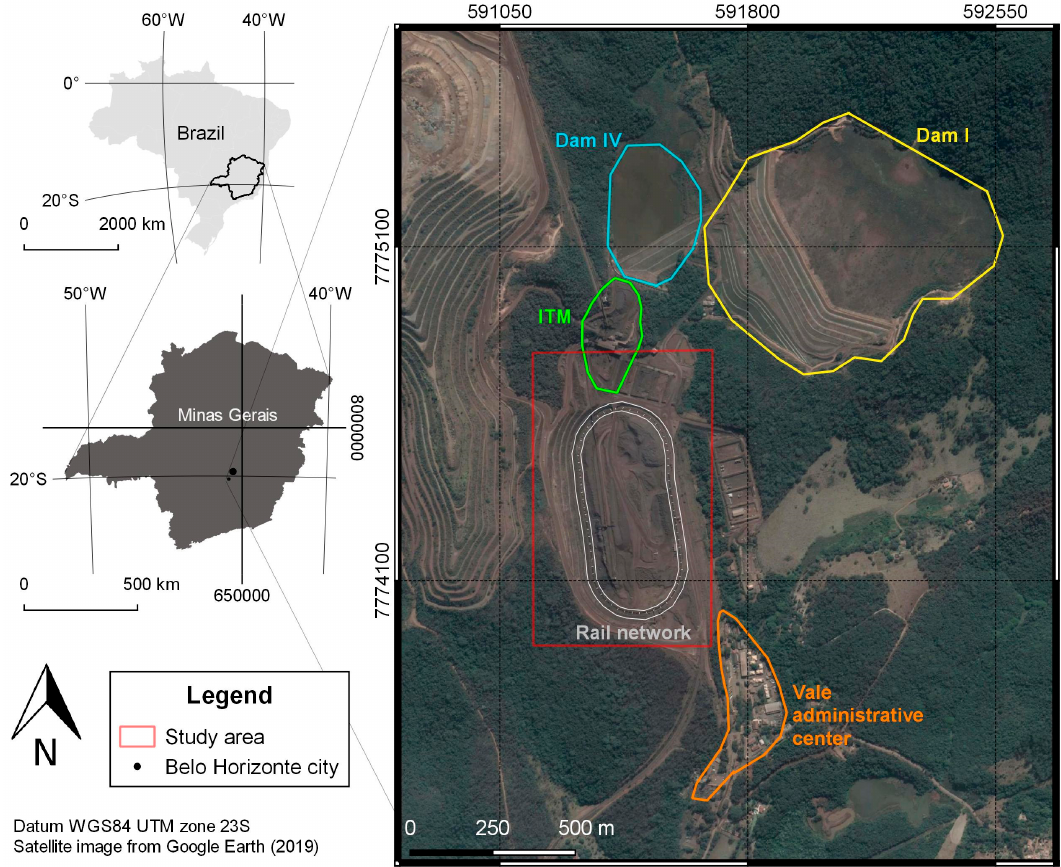
Figure 1. Location of Córrego do Feijão mine complex, tailings Dam I, cargo terminal and small rail network, and Vale's administrative center.